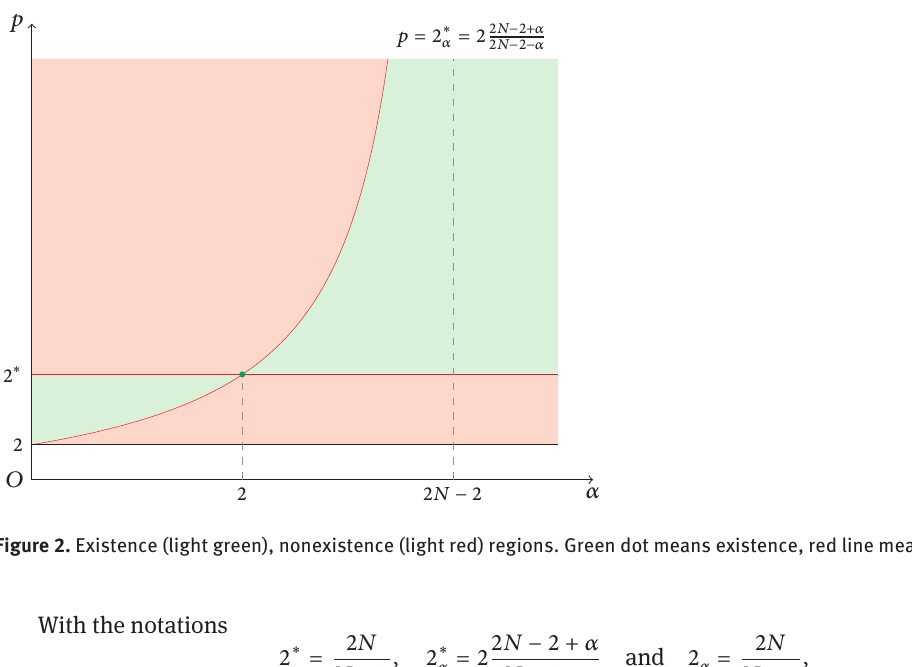
22𝑁 − 2 + 𝛼 = 2𝑁 − 2 − 𝛼 𝛼